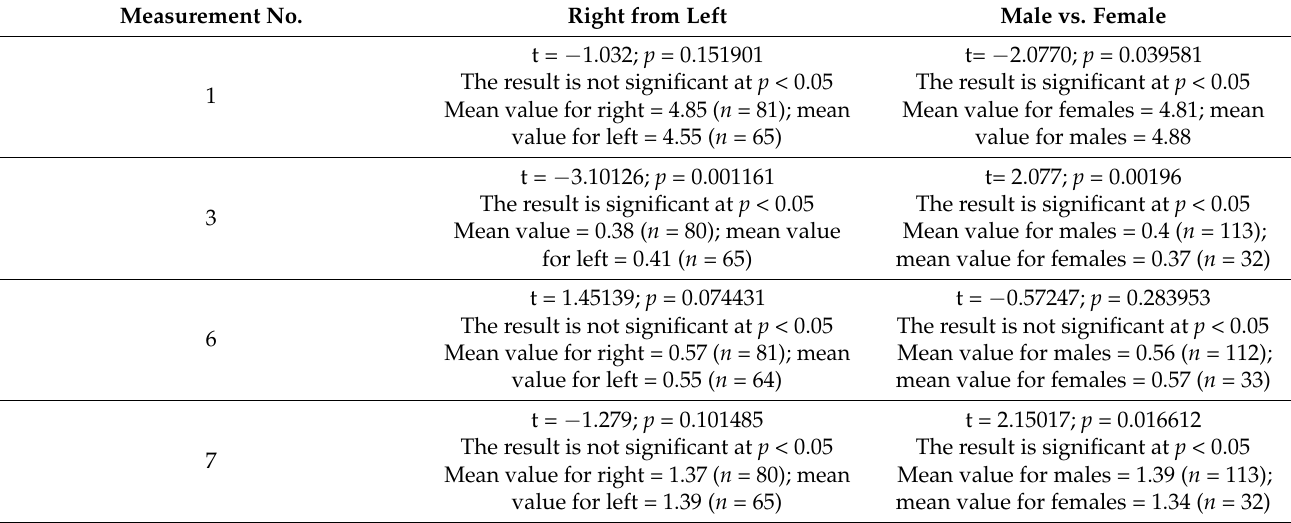
Table 7. Statistical results for the main measurements of the malleus (paired t -test for right and left and unpaired for male and female comparison).